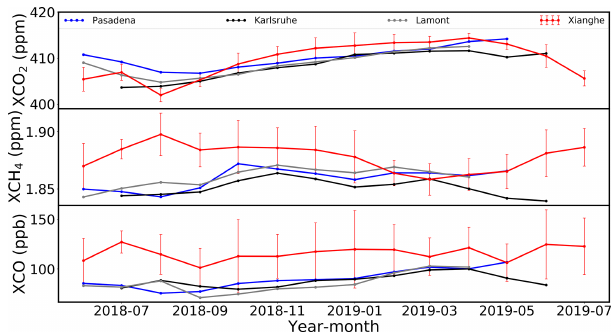
Figure 9. Monthly mean of XCO 2 , XCH 4 and XCO at Pasadena, Karlsruhe, Lamont and Xianghe. The error bars are the monthly SDs of XCO 2 , XCH 4 and XCO at Xianghe.